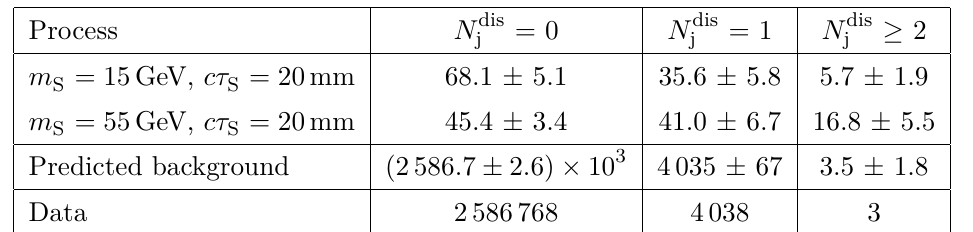
Table 3 . Observed data and estimated background yields in the search sample for the three N dis bins. The estimated background yields are obtained using the fit procedure described in section 5. Signal yields for two model points are also shown, where the Higgs boson decay branching fraction B (H → SS) is assumed to be